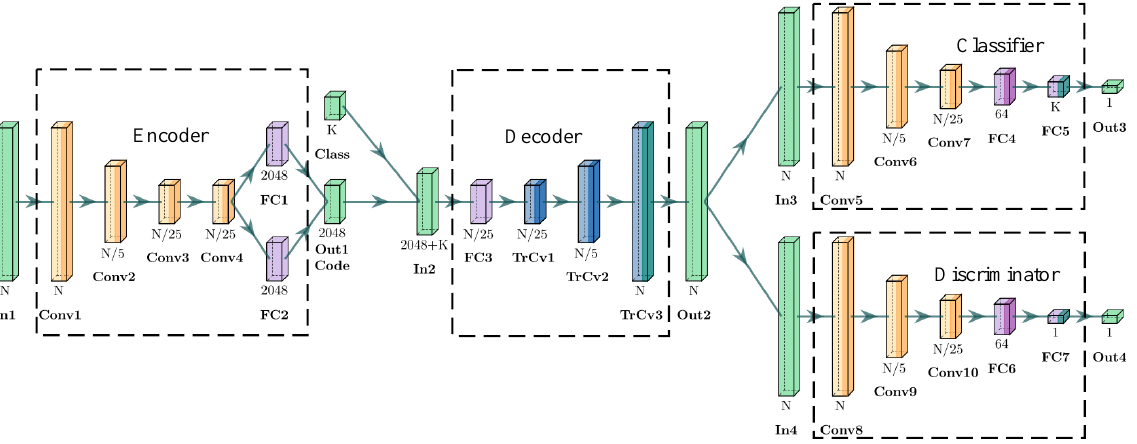
Figure 4. The designed 1-D CVAE-GAN model structure. The encoder consists of four convolution layers and two fully connected layers. A batch normalization layer and a ReLU activation layer are set after every convolution layer. The Fc1 and Fc2 FC layers output the mean and standard deviation vector of the Component code, respectively. The decoder consists of one FC layer and three transposed convolution layers. The FC layer is used to input codes and category labels. A ReLU activation layer is set after each of the first two convolution layers, and a sigmoid activation layer is set after the last transposed convolution layer. The discriminator and classifier are composed of